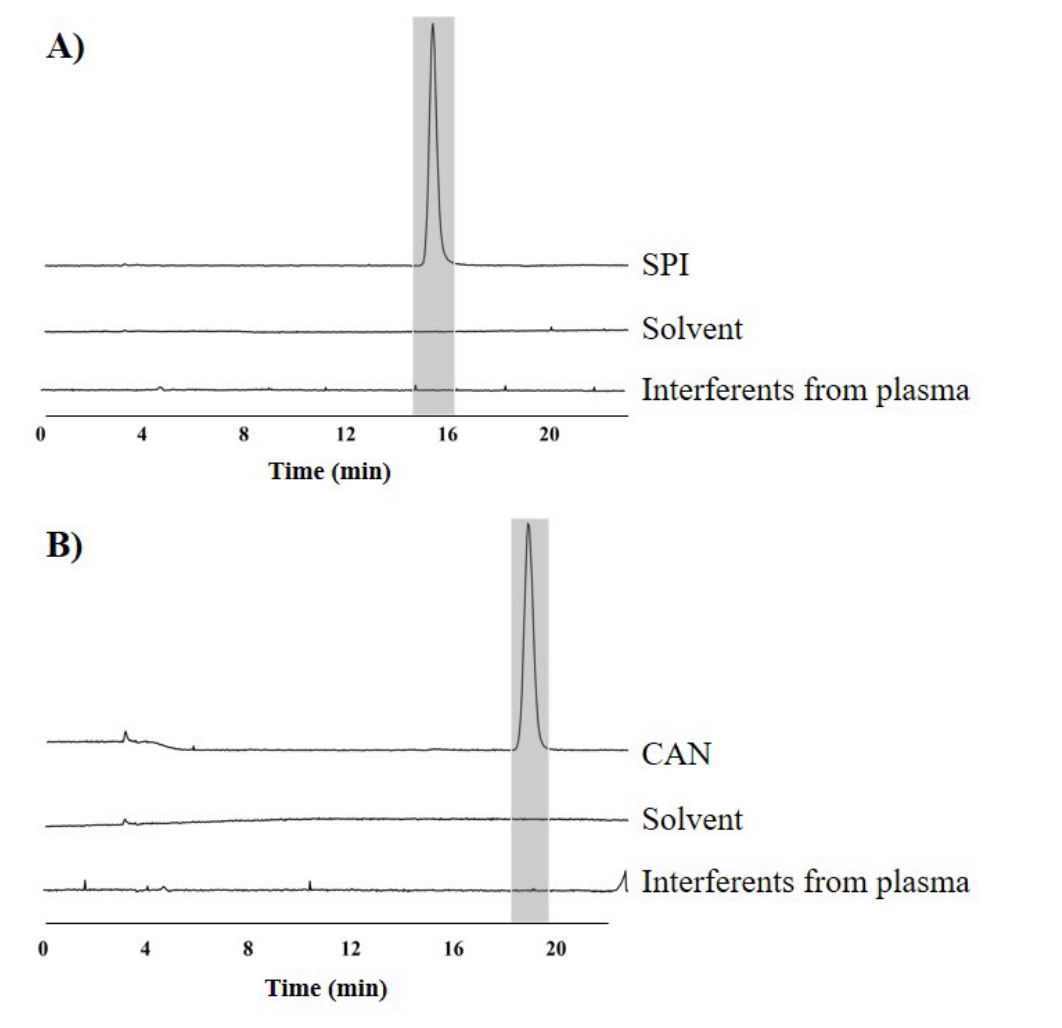
FIGURE 4 – Representative chromatograms of the blank injection of interferents from plasma and solvent (i.e., mobile phase)